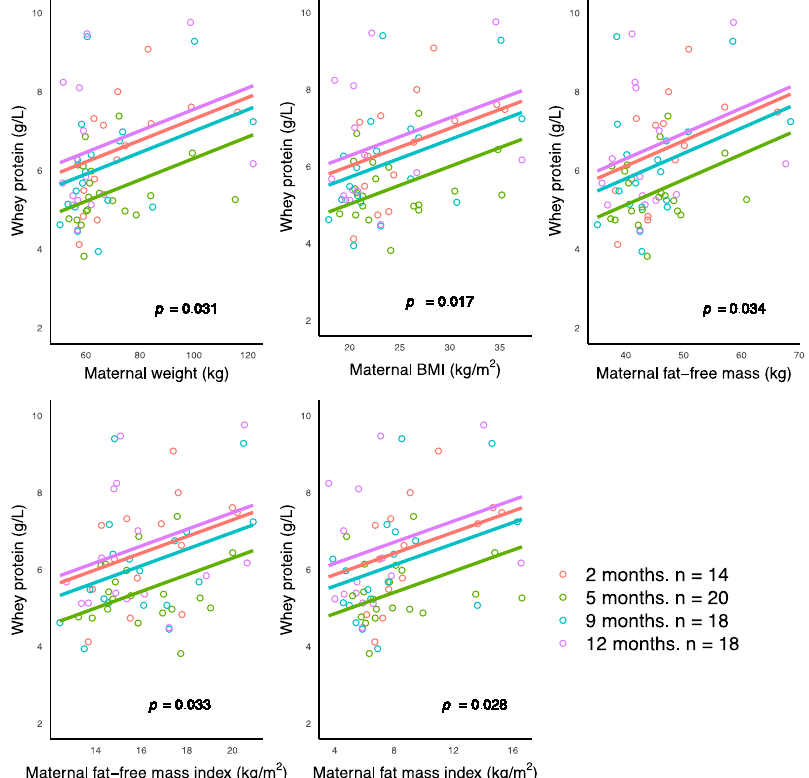
Figure 1. Significant positive associations between concentrations of human milk whey protein and maternal anthropometrics and body composition parameters measured with bioelectrical impedance spectroscopy. Lines represent linear regression and grouped by the month of lactation.